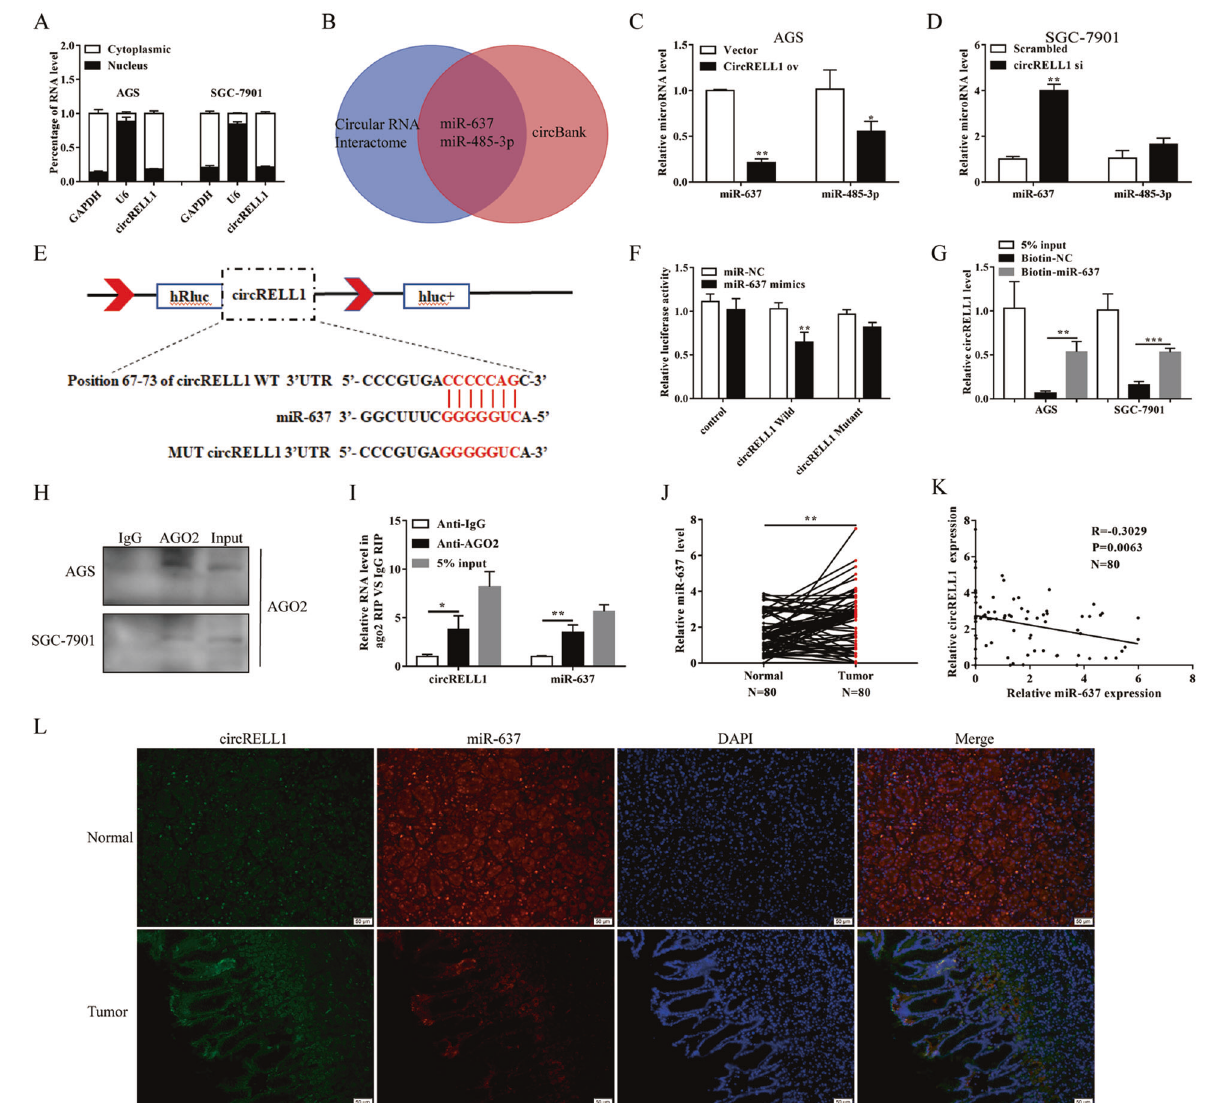
Fig. 6 CircRELL1 acts as a miRNA sponge for miR-637. A qRT-PCR analysis was applied to measure subcellular localization of circRELL1 in GC cells. B Target miRNAs of circRELL1 were predicted by Circular RNA Interactome and circBank. C , D The relative miRNAs levels in the AGS and SGC-7901 cells after different treatments. E The predicted binding sites between circRELL1 and miR-637. F Dual-luciferase assay was performed to investigate the direct binding between circRELL1 and miR-637 in HEK-293 cells. G CircRELL1 were pulled down by biotin-labeled miR-637 and con fi rmed by qRT-PCR in AGS cells. H , I The assessment of the enrichment in Ago2 immunoprecipitates, as determined by WB and qRT-PCR. J qRT-PCR analysis of miR-637 levels in the paired GC and adjacent normal tissues. K Correlation analysis of the relationship between circRELL1 and miR-637 in 80 GC tissues. L FISH analysis of circRELL1 and miR-637 levels in GC and adjacent tissues. Results are presented as mean ± SD of three independent experiments. ** P < 0.01, *** P <